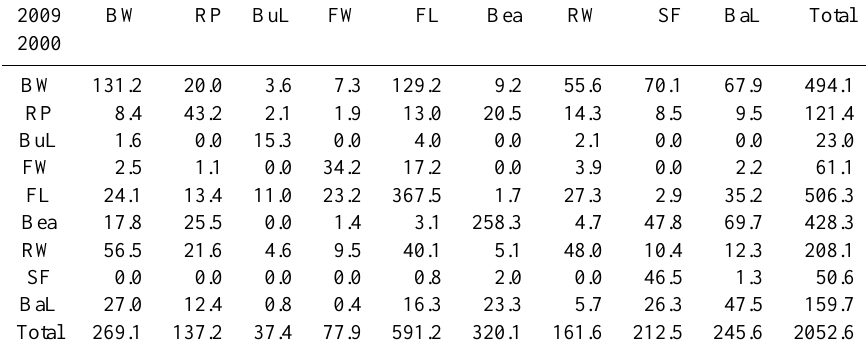
Table 2. The transfer matrix of landscape types from 2000 to 2009 in the modern YRD (km 2 ) (BW: bush wetland, RP: reservoir and pond, BuL: building land, FW: forest wetland, FL: farm land, Bea: beaches, RW: reed wetland, SF: salt field, BaL: bare